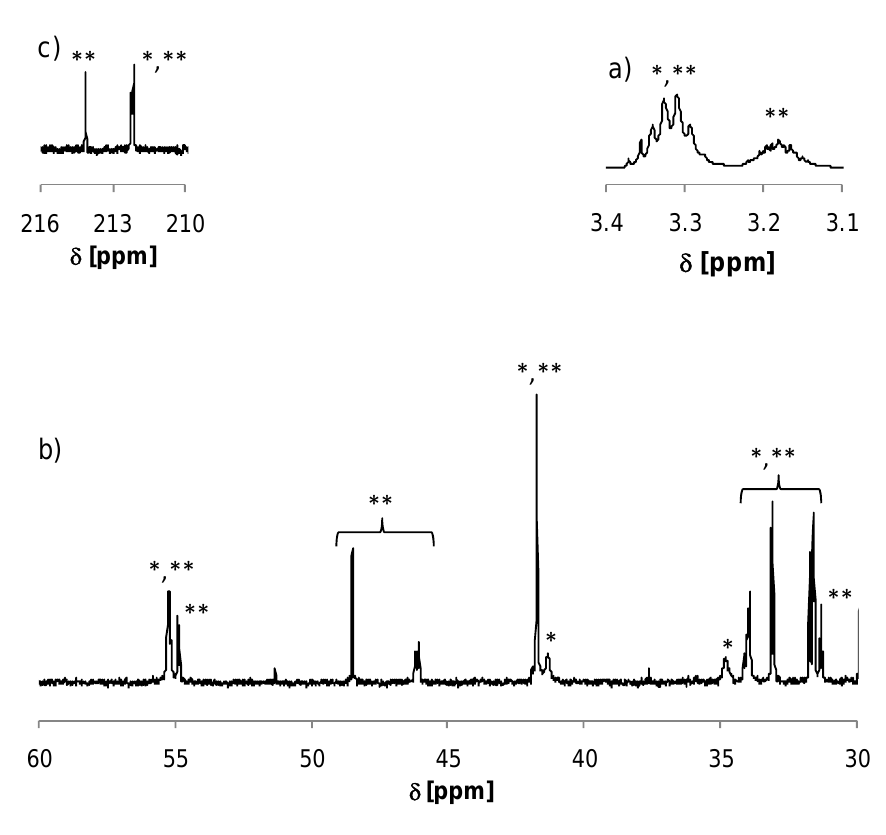
Figure 3. Enlargements of the 1 H-NMR ( a ) and 13 C-NMR ( b , c ) spectra of the mixture of compounds 4 (*) and 5